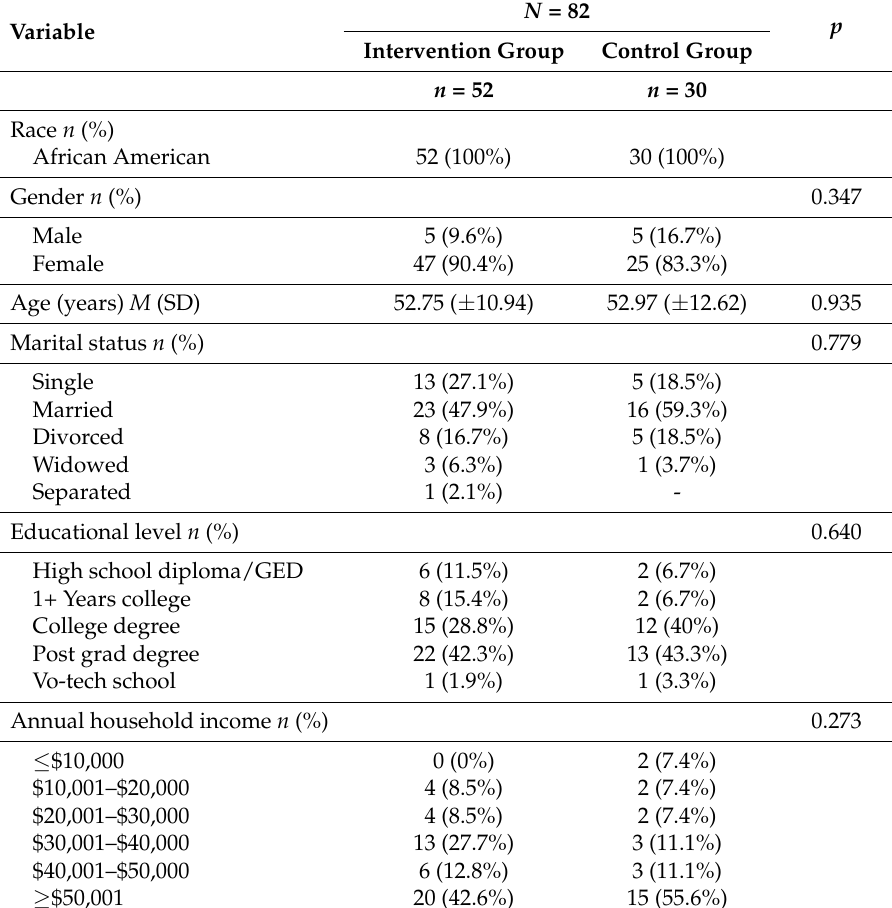
Table 1. Demographic